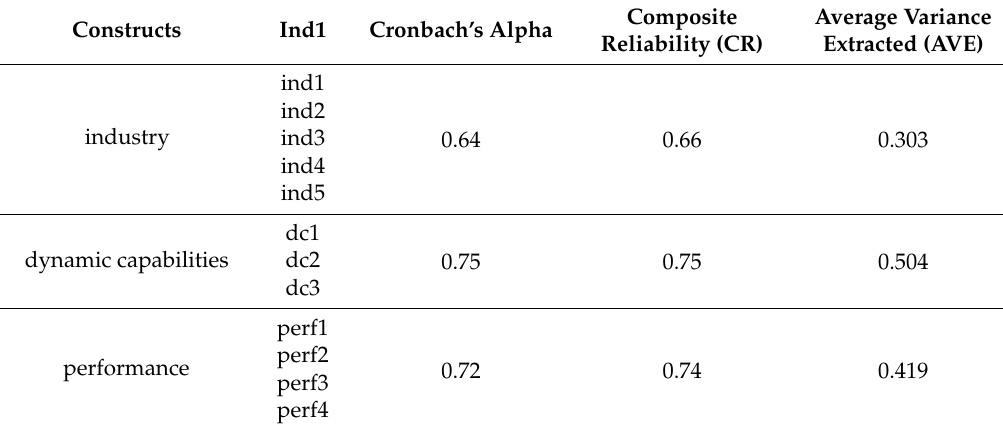
Table 4. Reliability and convergent